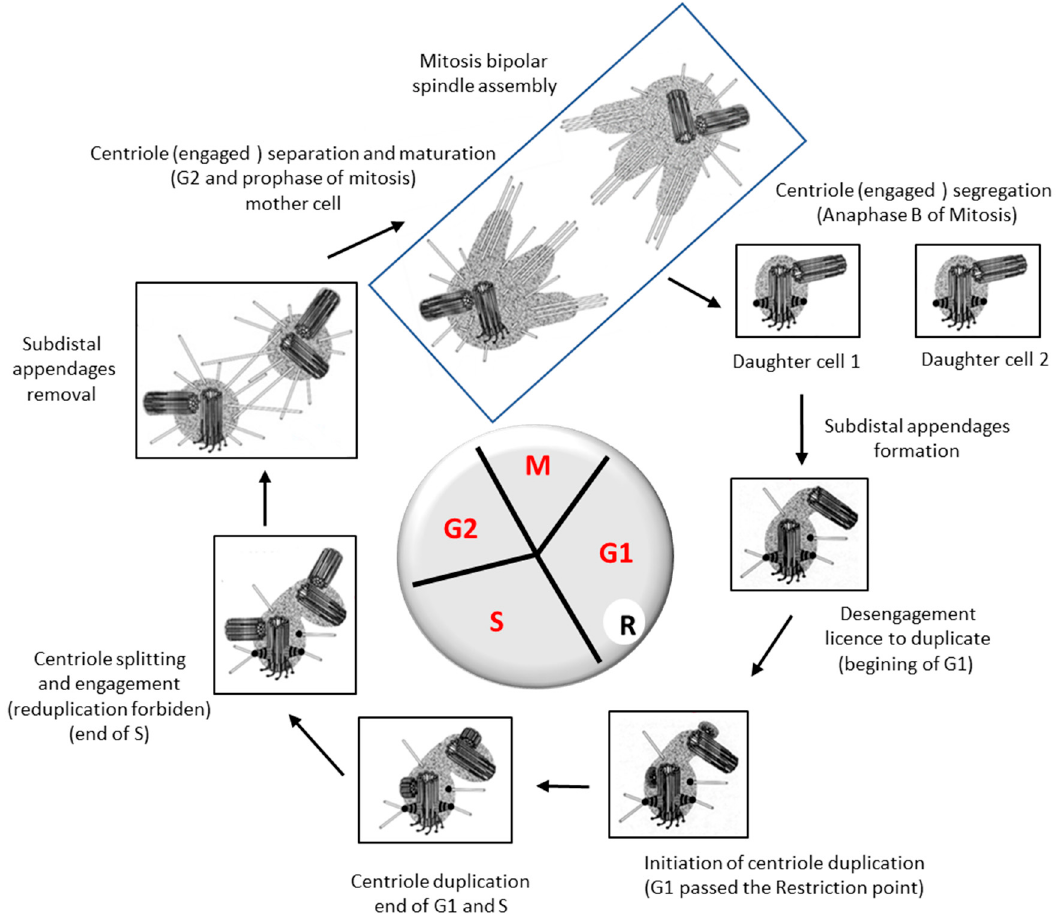
Figure 7. Stages of the centriolar cycle and their relationship with the stage of the cellular (nuclear) cycle.